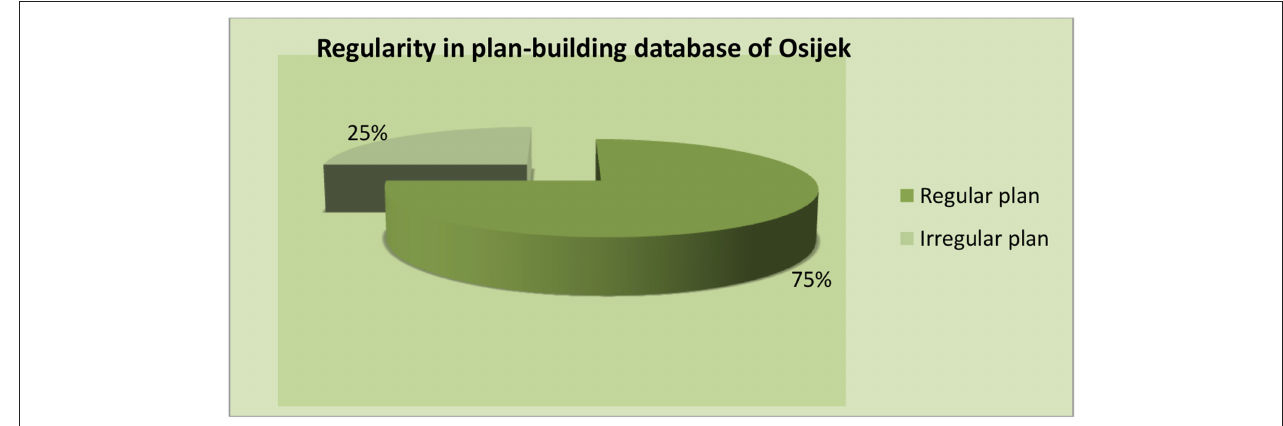
FIGURE 3 | Regularity in plan for buildings from Osijek